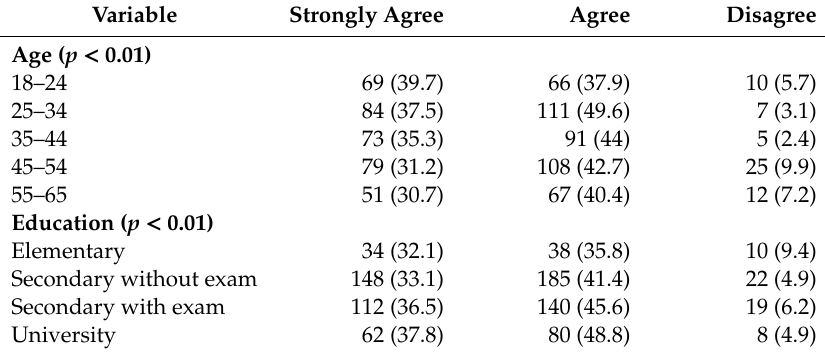
Table 2. Sociodemographic factors and climate change beliefs among the general population in the Czech Republic, N